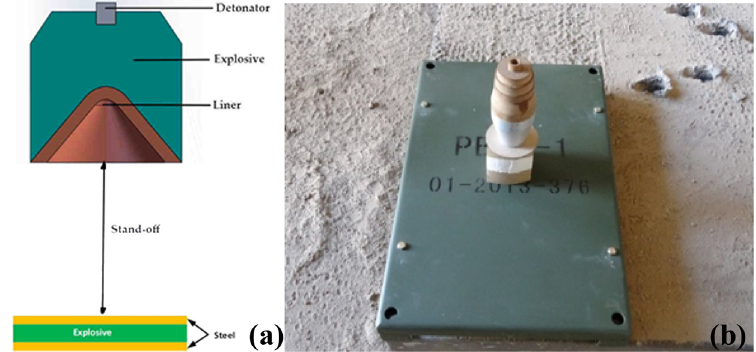
Figure 4: ( a ) Experimental setup schematic and ( b ) layout of the experimental site.